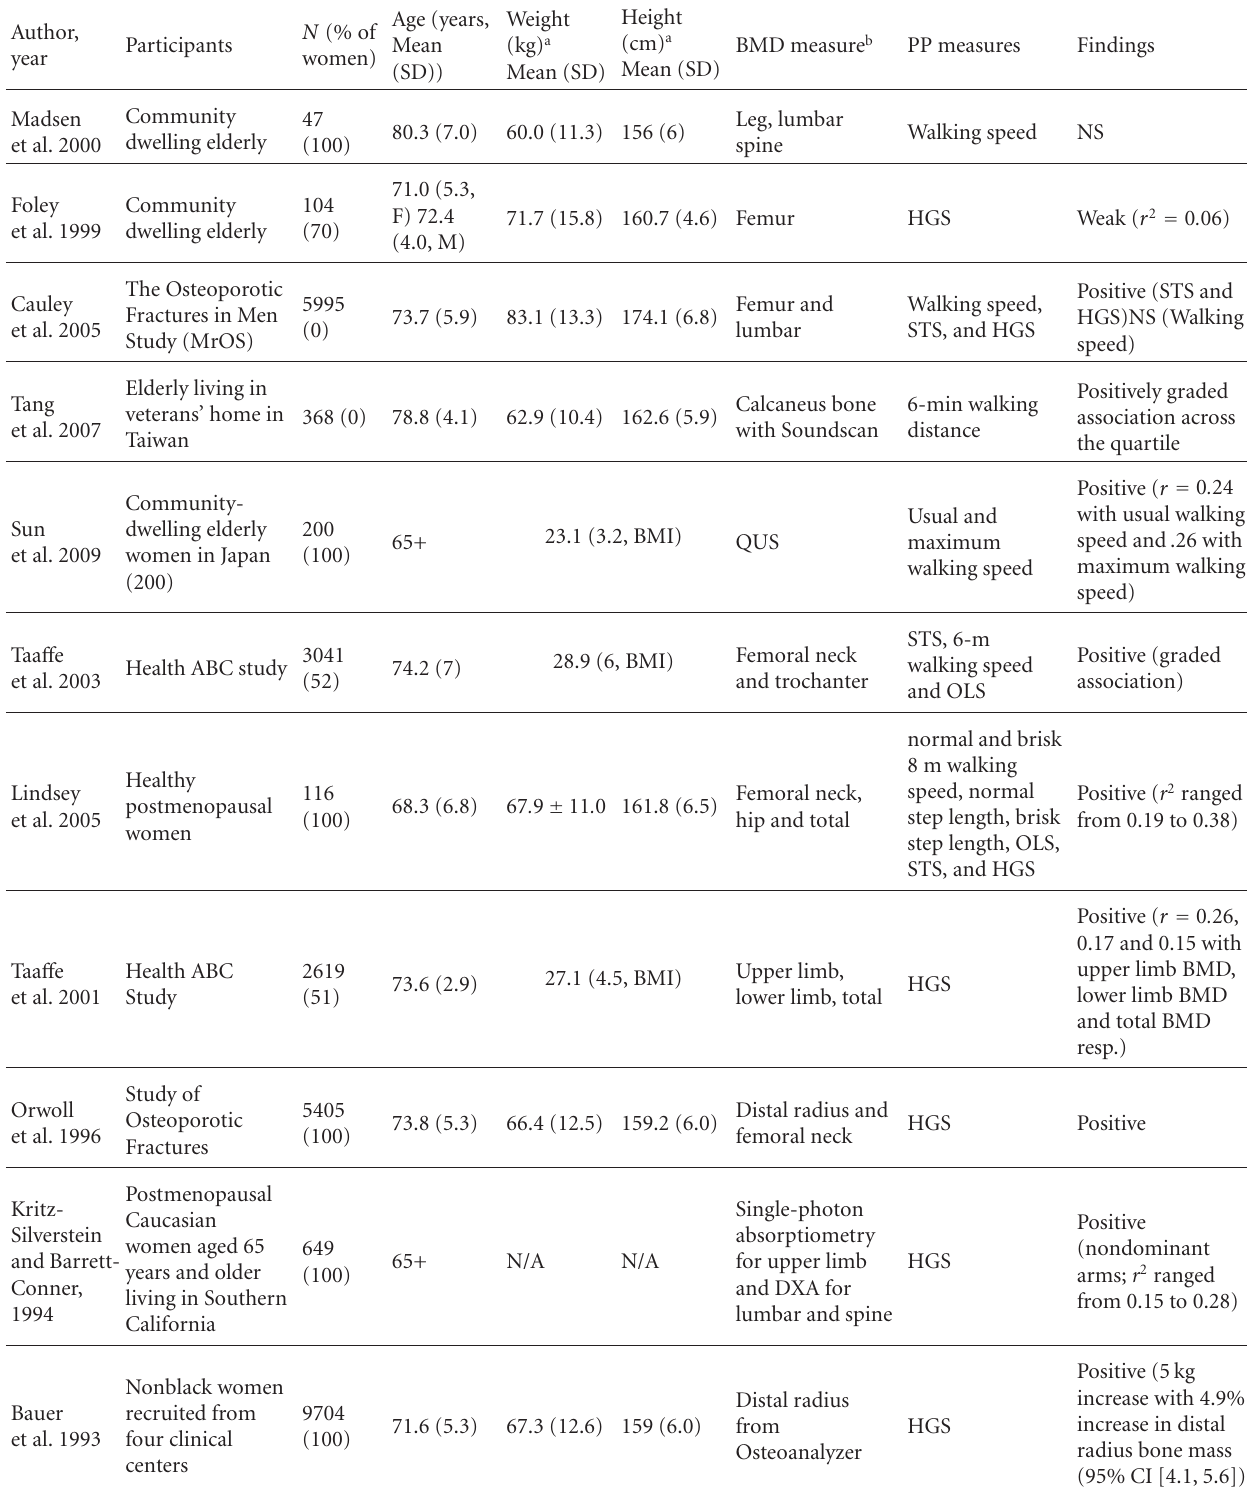
Table 2: Summary of studies of the relationship between physical performance (PP) and bone mineral density (BMD).